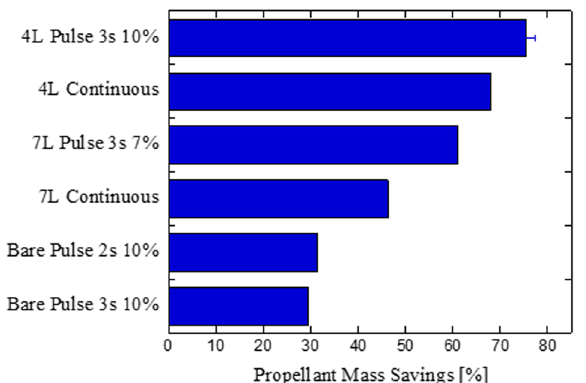
Fig. 6 Performance gains of pulse fl ow and coated tube in microgravity: 550 kPa. Source pressure, 0.05 G level (g/g 0 ) — F2 (bare continuous) vs F3 (bare pulse 3 s 10%) vs F4 (bare pulse 2 s 10%) vs F13 (7 L continuous) vs F14 (7 L pulse 3 s 7%) vs F22 (4 L continuous) vs F28 (4 L pulse 3 s 10%) — propellant mass savings as compared to base case of Flight_Day1_2 (continuous fl ow and bare